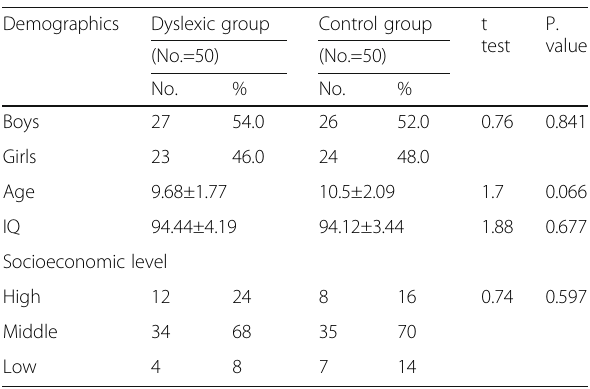
Table 1 Demographic characteristics of dyslexic students and controls